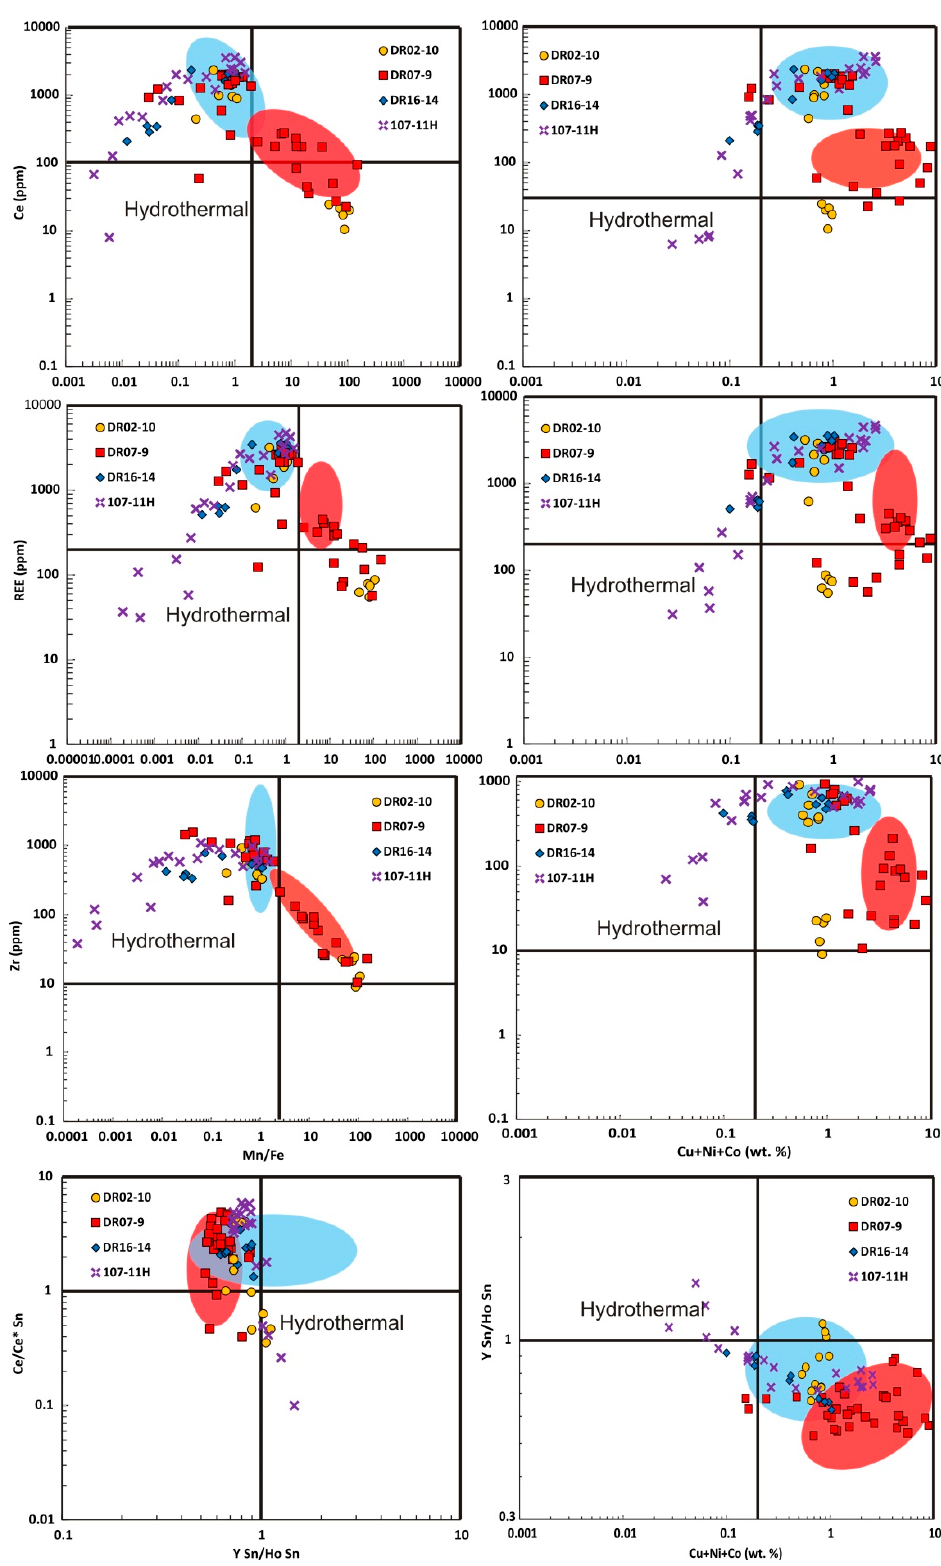
Figure 13. Several binary diagrams of the High Field Strength Elements (HFSE) according to [31] in which have been plotted LA-ICP-MS analysis of the selected samples. Hydrogenetic (blue) and diagenetic (orange) fields have been evidenced; the hydrothermal field is indicated in every diagram. The layer type 2 found in nodules is clearly similar to the bright laminae found in crusts DR02- 10 and DR07-9. EPMA analysis of CCZ nodules provides contents of Mn of up to 40 wt. % and very low contents of Fe (around 1 wt. %). This layer type also shows high Ni and Cu (respectively 2 and